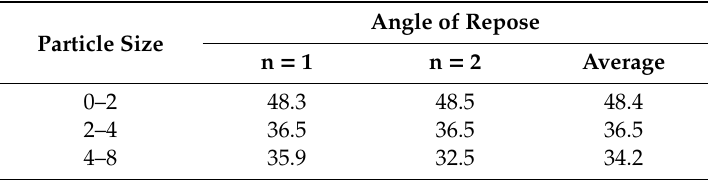
Table 1. Experimental results of angle of repose.